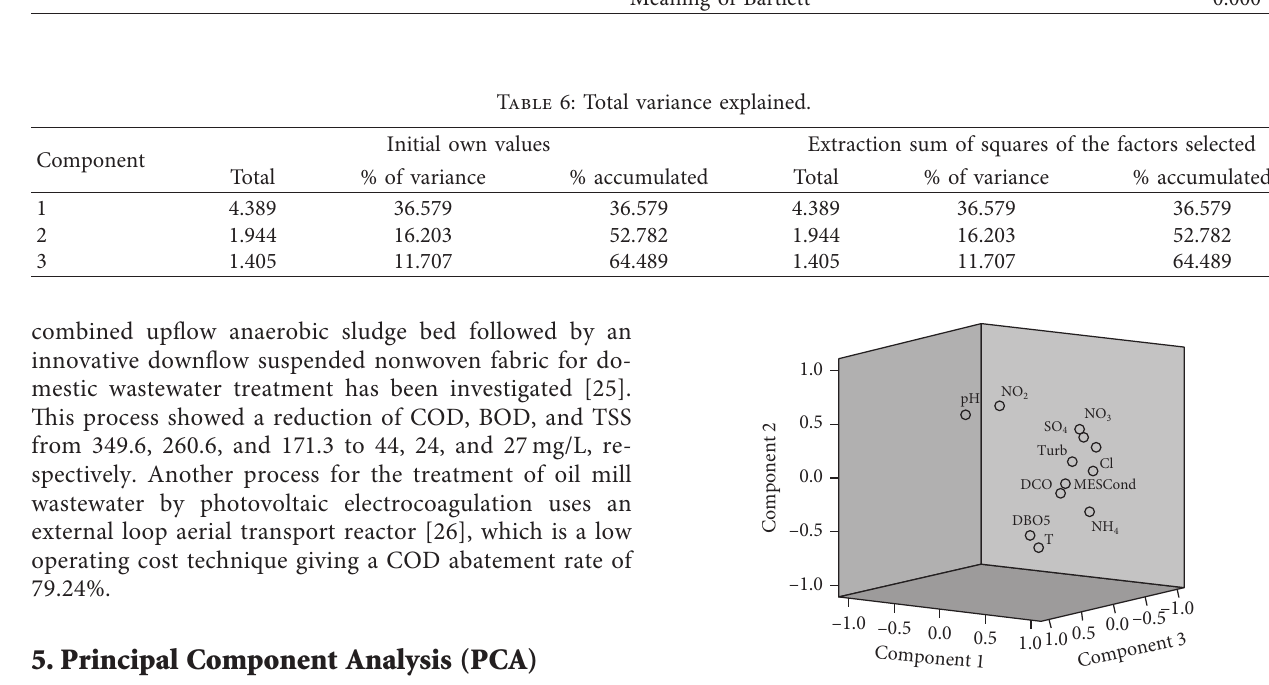
Figure 3: Physicochemical variables on the three-axis plane